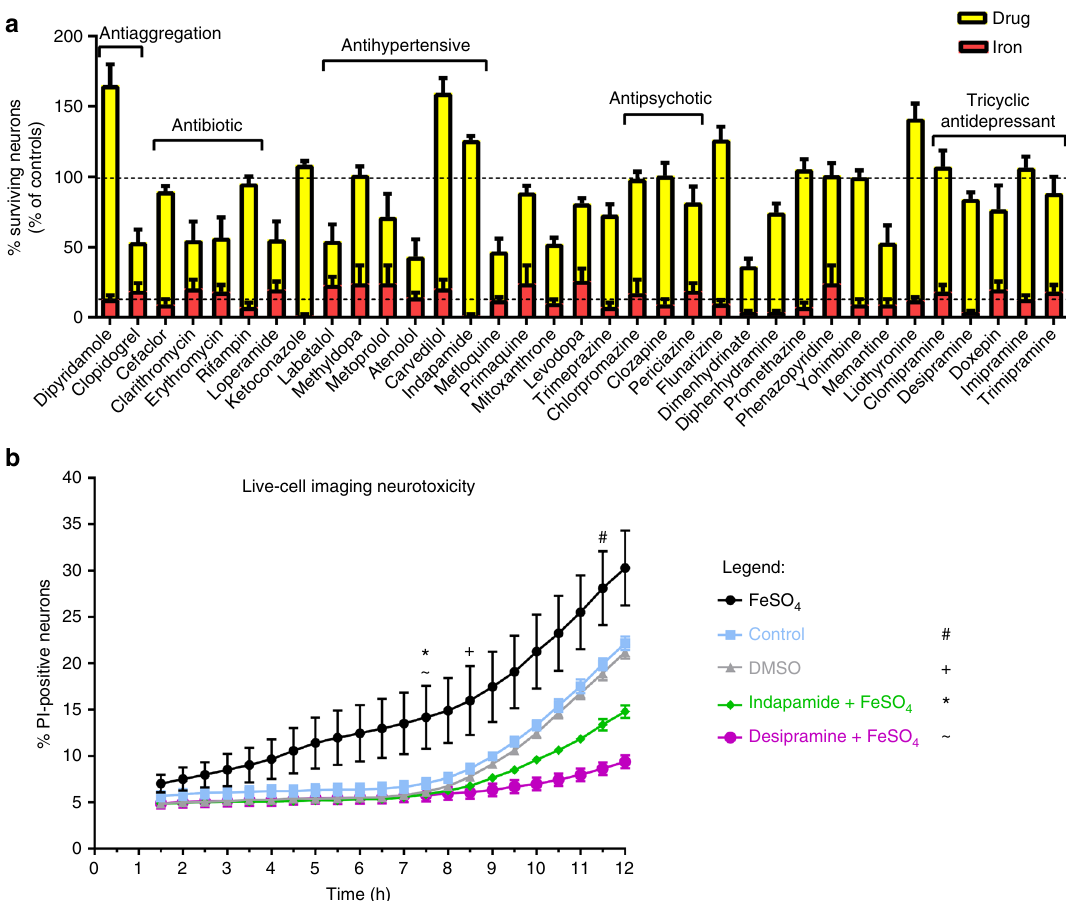
Fig. 2 Summary of compounds that attenuate iron-mediated neurotoxicity. Shown are all 35 generic drugs that prevent iron-mediated neurotoxicity ( a ). The number of neurons in each well of a given experiment was normalized to the number of neurons of the respective untreated control condition (100%). The corresponding FeSO 4 -treated condition (red) was also normalized to the respective control. Some of the major drug classes are depicted in the fi gure. Shown are the mean ± SEM of 2 – 4 independent experiments, performed in quadruplicates (thus, 8 – 16 wells per treatment across experiments are depicted in the fi gure). b shows the results from live-cell imaging of neurons (see examples in Supplementary Video 1), challenged with FeSO 4 in a concentration of 50 µ M. Upon pre-treatment with indapamide or desipramine 1 h before the addition of iron, the number of propidium iodide-positive cells was signi fi cantly reduced after 7.5 h and even below the level of the untreated control condition after 12 h, suggesting a strong neuroprotective effect. Live-cell imaging was performed over 12 h, where images were taken every 30 min. The time-point from which signi fi cant changes from FeSO 4 were observed for each group is marked with a symbol (# control; + DMSO; * indapamide; ~ desipramine). Shown are means ± SEM of n = 3 wells per condition. Results were analyzed